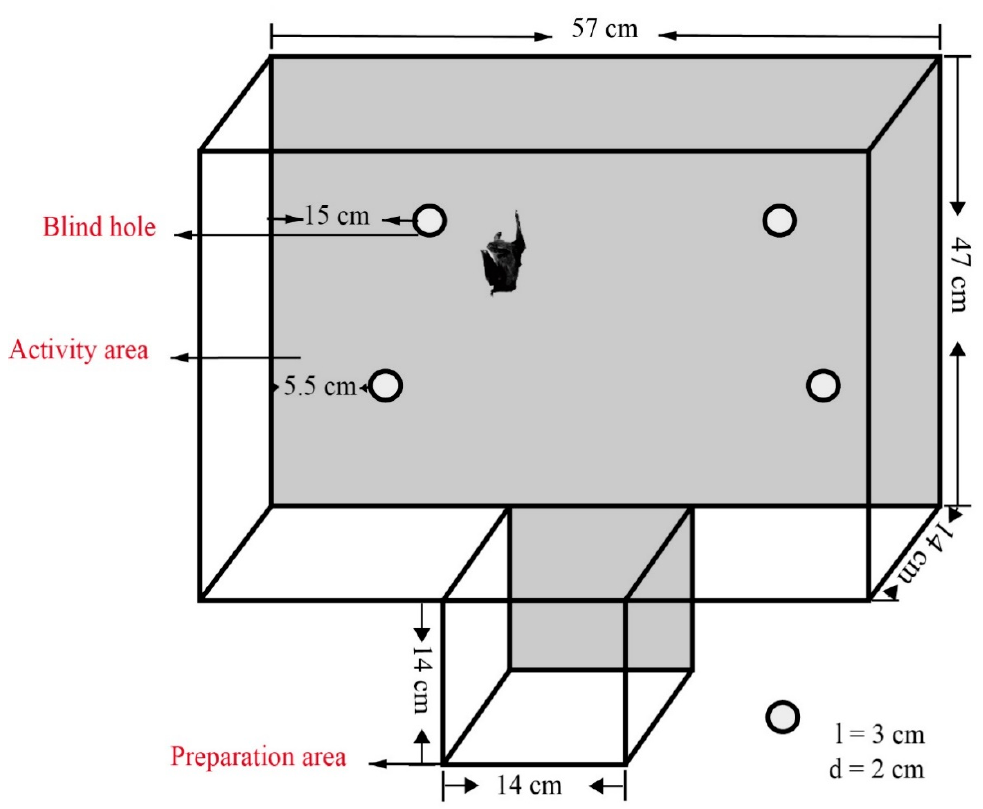
Figure 1. Experimental setup for the hole-board test: The hole board consists of the activity area (57 × 42 × 14 cm) and the preparation area (14 × 14 × 14 cm) separated by sliding doors. Four blind holes are located on the inner surface for bats to explore. The shaded area is the area covered by the gauze.